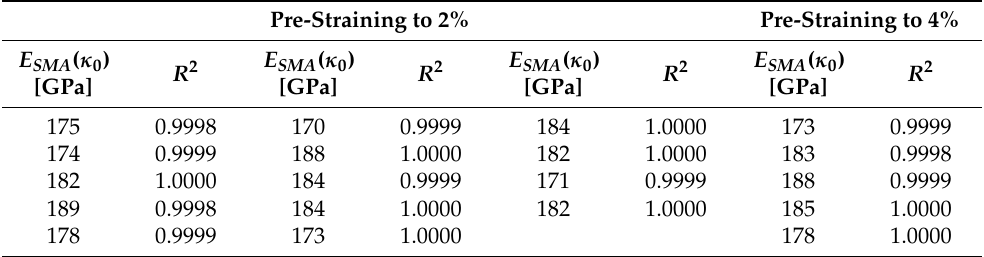
Table 2. The detailed E SMA ( κ 0 ) values of 19 pre-straining experiments.